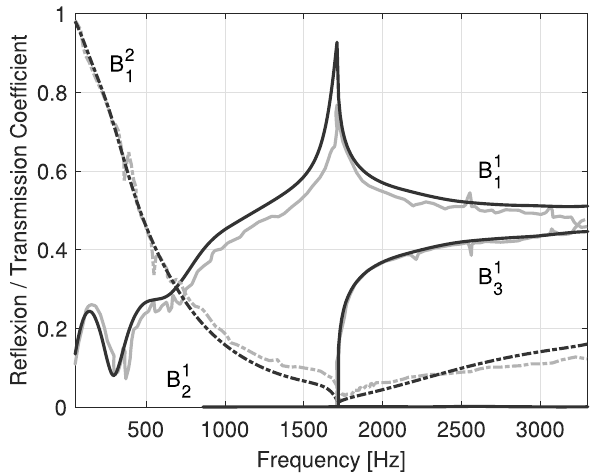
Figure 4. Coef fi cients of the scattering matrix, measured (gray) and computed